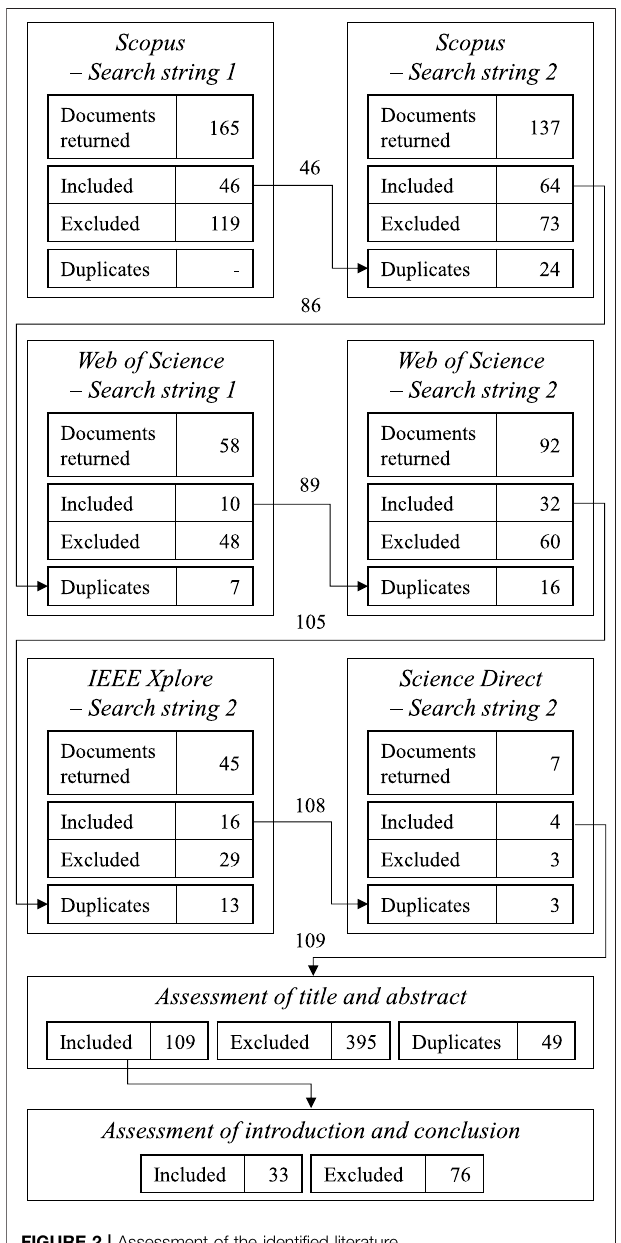
FIGURE 2 | Assessment of the identi fi ed